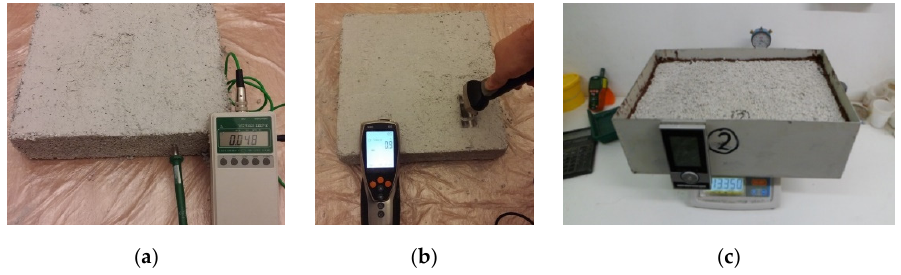
Figure 5. Control measurement of: ( a ) thermal conductivity; ( b ) material moisture; ( c ) measurement of vapor permeability.